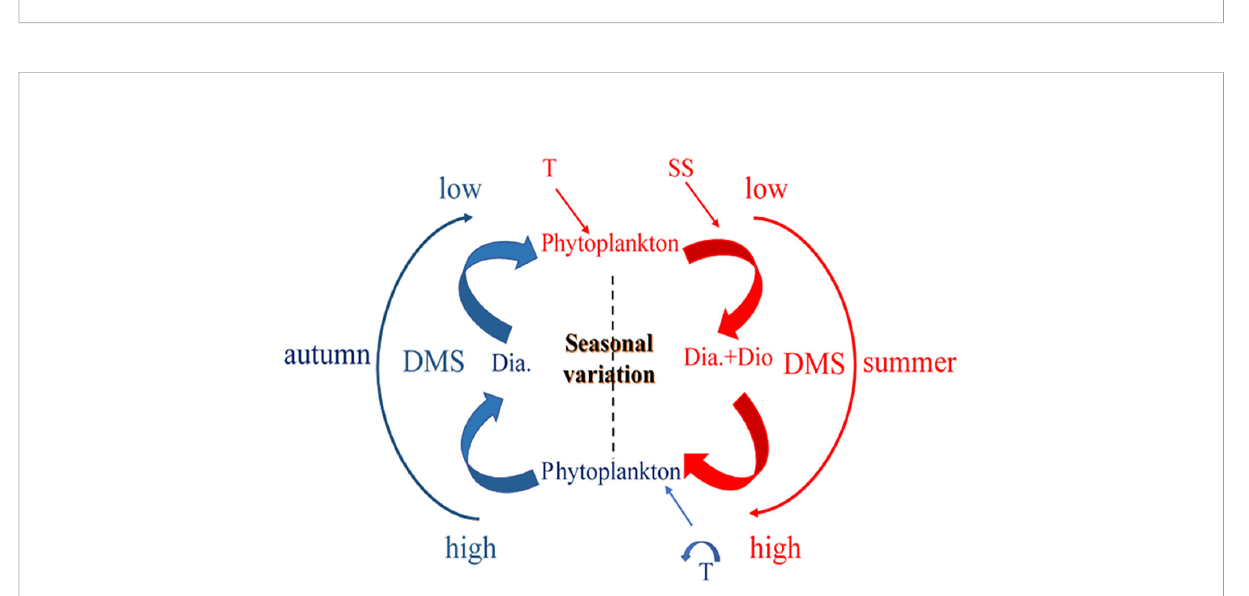
FIGURE 11 Schematic depicting the seasonal cycles in the concentrations of DMS in BS and